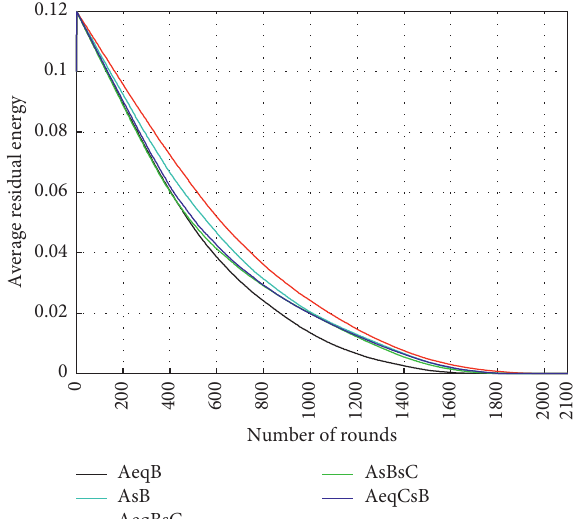
Figure 6: Comparison of active nodes in each round.